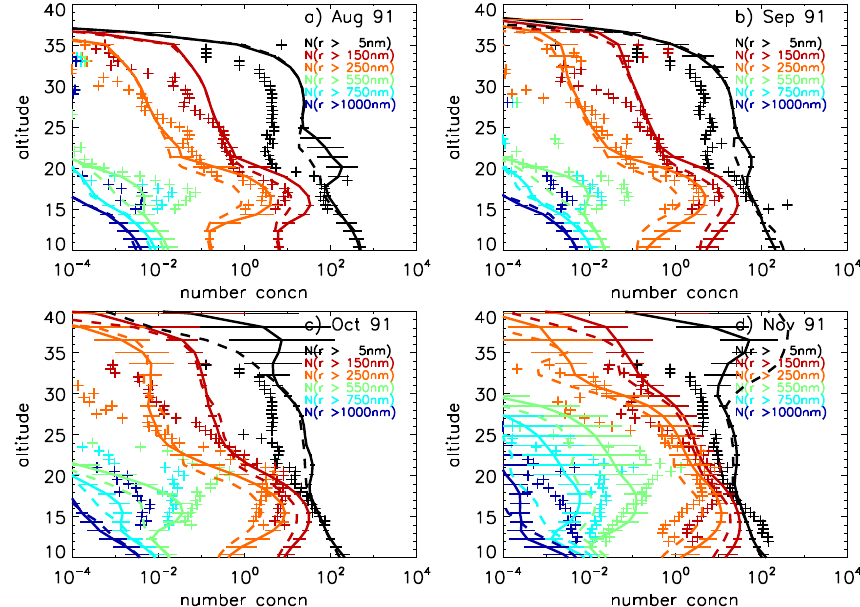
Figure 9. August, September, October, November 1991 profiles of size-resolved number concentrations of particles (cm − 3 ) with radii larger than 5, 150, 250, 550, 750 and 1000nm from Laramie (41.3 ◦ N, 105.5 ◦ W) are shown with plus (+) symbol. Solid and dashed lines show aerosol profiles from the runs A_Control20 and B_Control10, respectively, highlighting the region where the model predicts perturbation in the aerosol profiles. Horizontal coloured lines represent standard deviations (1 σ ) in number concentrations for a given month calculated from daily values for run A_Control20.